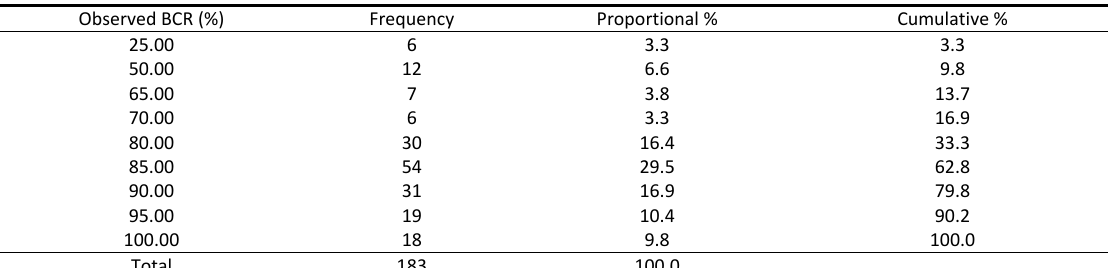
Fig. 7: Noncomplying land subdivisions in 2020